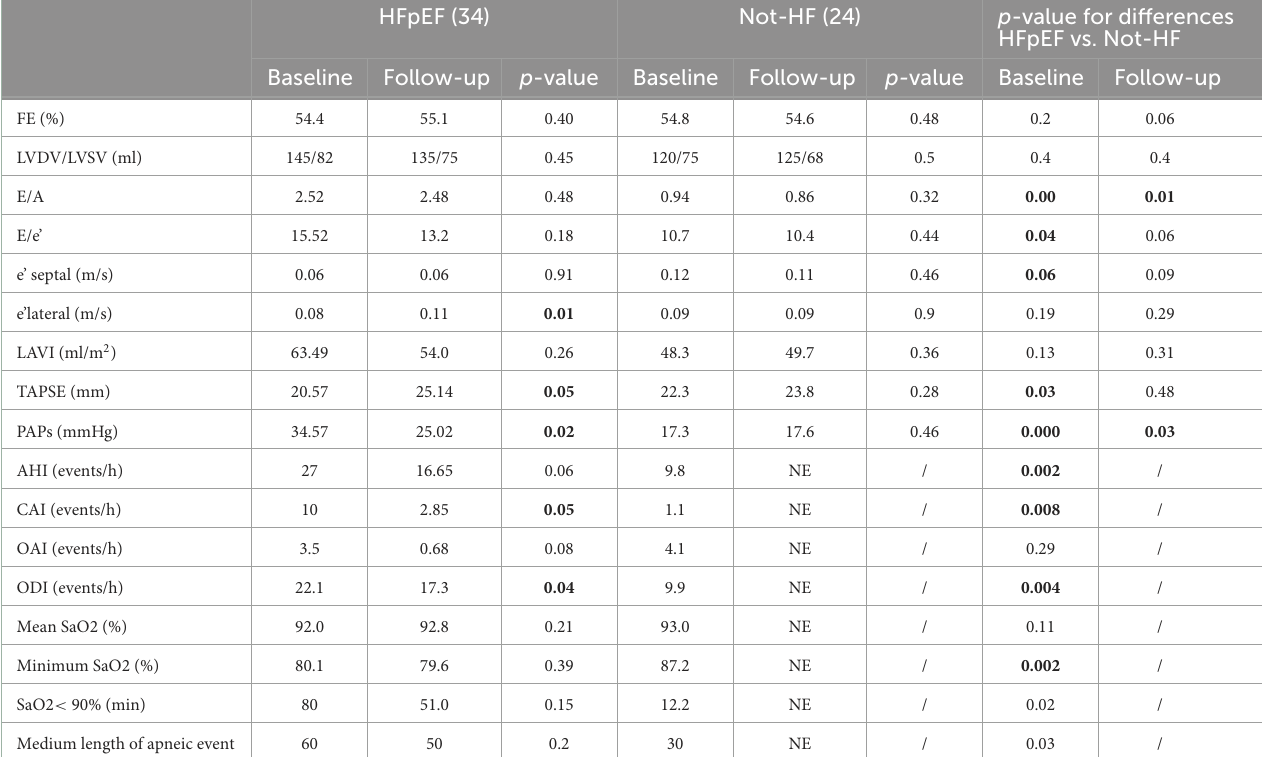
TABLE 4 Echocardiographic and polysomnographic values. HFpEF (34) Not-HF (24) p -value for differences HFpEF vs. Not-HF Baseline Follow-up p -value Baseline Follow-up p- value Baseline